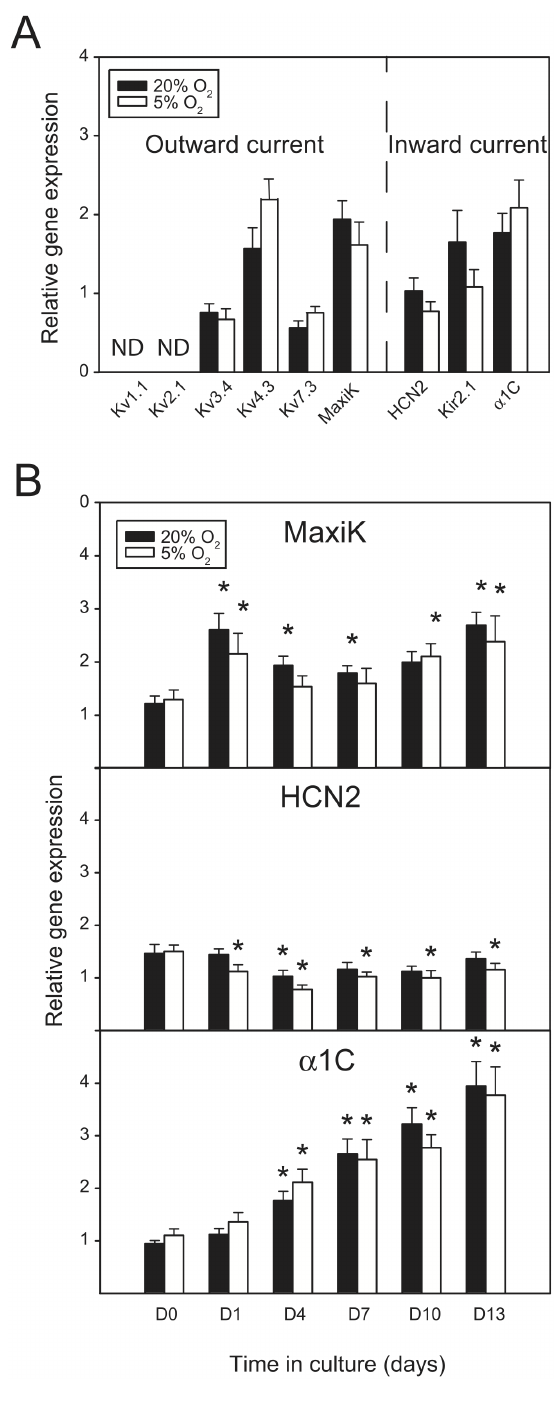
Figure 5. Ion channel gene expression in response to hypoxia. (A) Transcriptional expression of selected outward and inward ion channel genes (Kv1.1, Kv2.1, Kv3.4, Kv4.3, Kv7.3, MaxiK, HCN2, Kir2.1, and a 1C) was assessed after 4 days of culture in standard normoxic conditions and in hypoxia. (B) Expression of MaxiK, HCN2 and a 1C, genes during 13 days of culture in 20% and 5% oxygen concentration. The data were obtained from repeated experiments using all three cell cultures (n=6). The asterisks (*) denote a statistically significant difference (p , 0.05) with respect to D0.